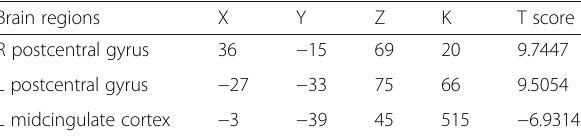
Table 2 Significant differences in the SMN in patients with MwoA compared with HCs